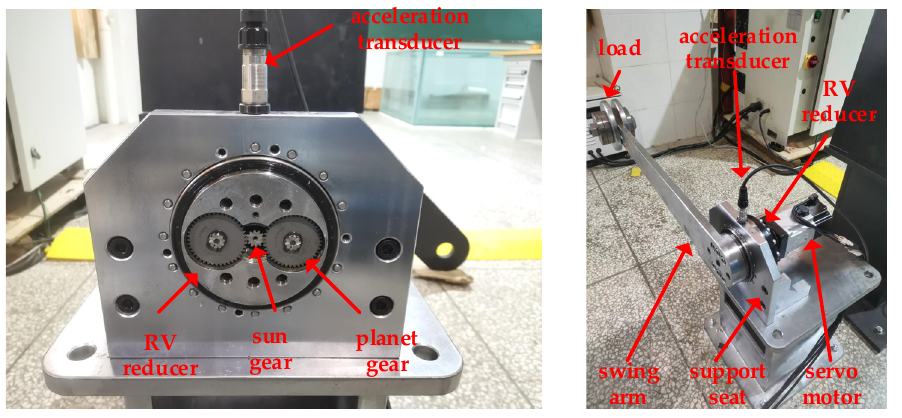
Figure 8. RV reducer fault simulation experimental bench.